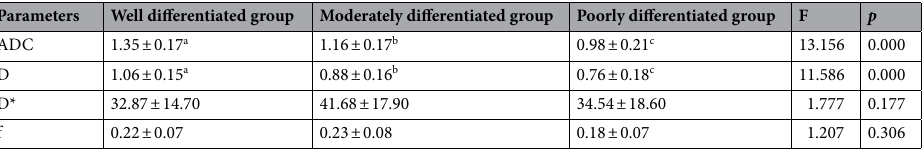
Table 1. Comparison of IVIM-DWI parameters in different HCC histologic differentiation groups. The units for ADC, D, and D* were all × 10 −3 mm 2 /s. Different superscript letters indicate significant differences in the parameters between various groups.